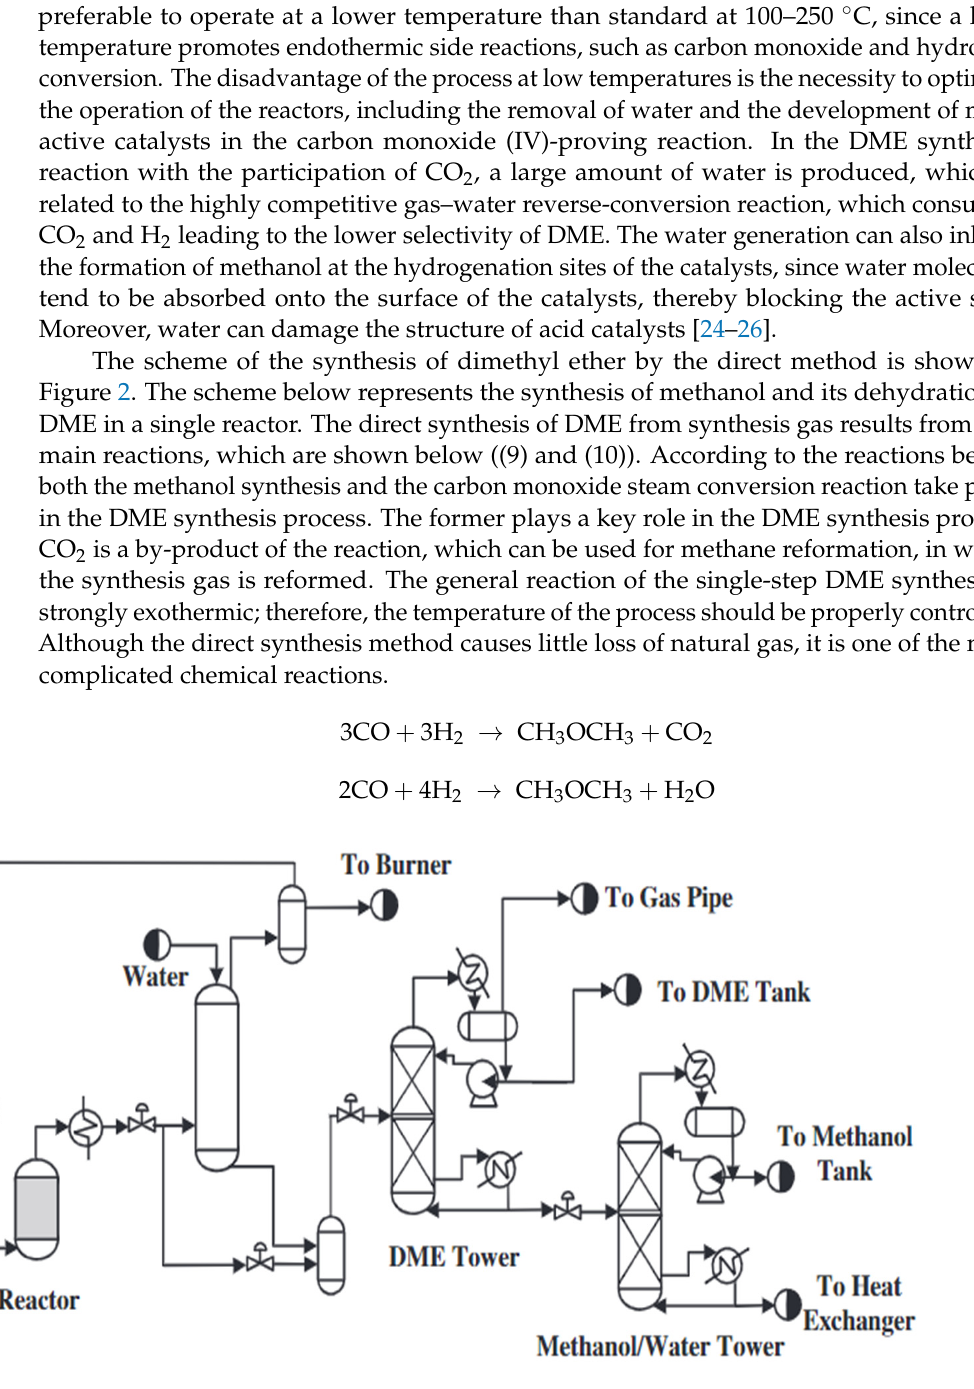
Figure 2. A scheme of the direct synthesis of dimethyl ether. Reproduced with copyright permission from [1]